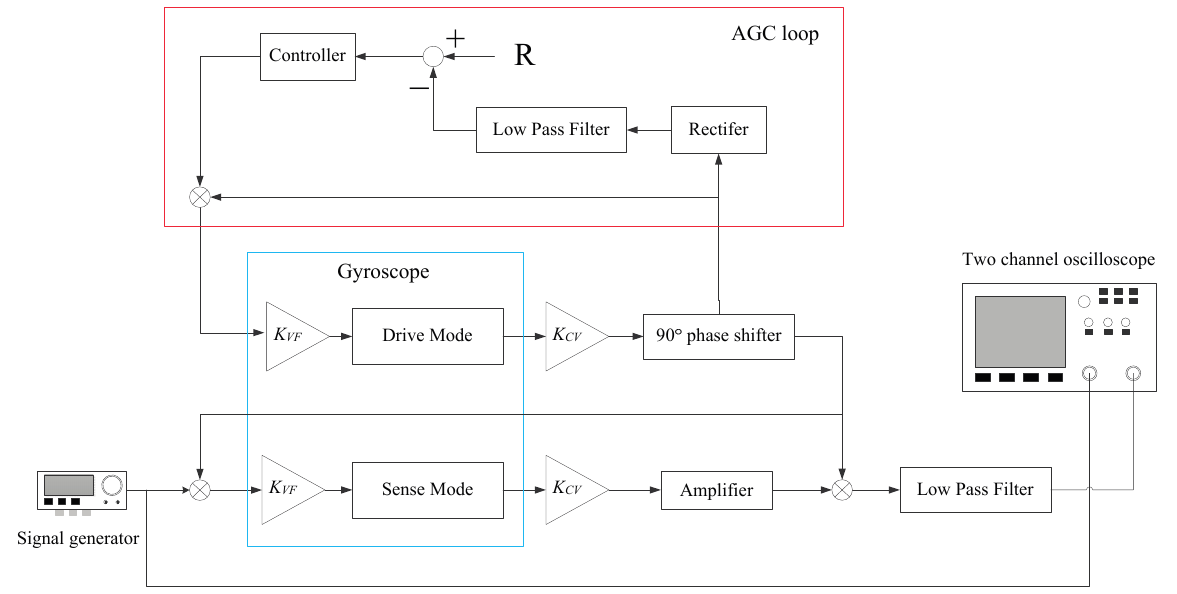
Figure 11. The functional block diagram of virtual rate-table